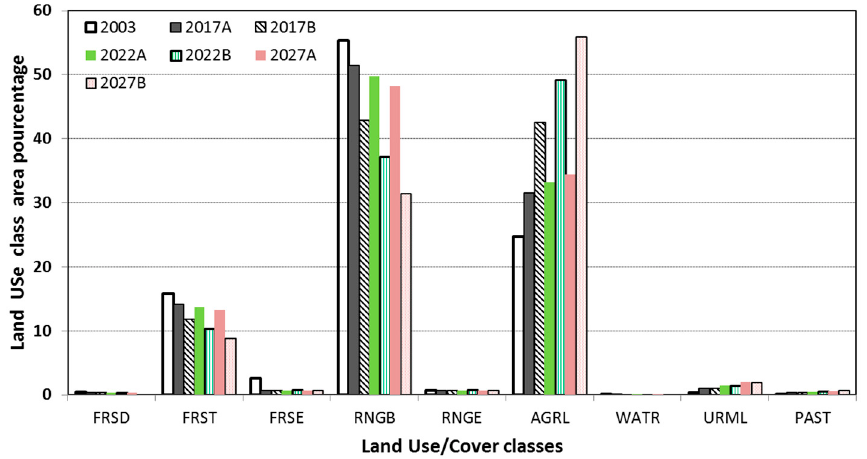
Figure 6. Change in land use scenario. The different land use types are forest-deciduous (FRSD), forest-mixed (FRST), range-bush (RNGB), agriculture (AGRL), forest-evergreen (FRSE), range-grasses (RNGE), water bodies (WATR), pasture (PAST), and urban area (URML). Hydrology 2018 , 5 , x; doi : FOR PEER REVIEW